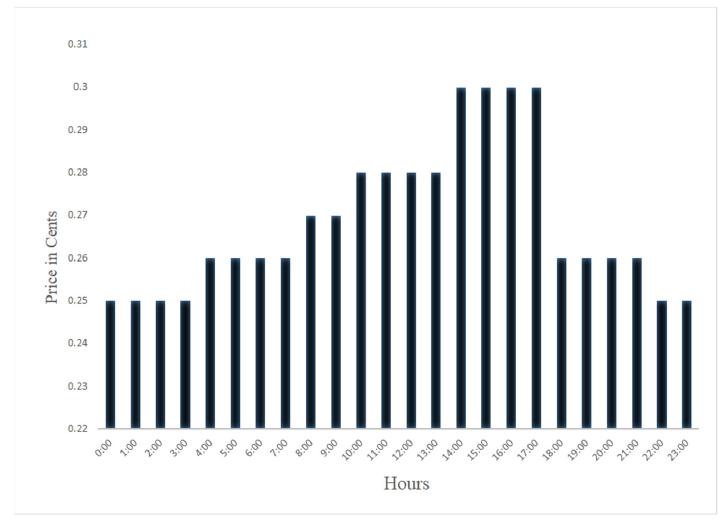
Figure 4. Dynamic pricing of kWh.